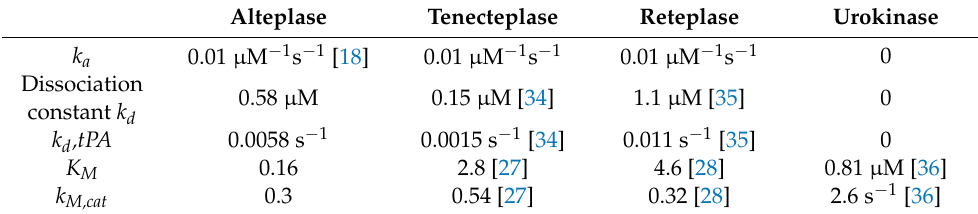
Table 2. Kinetic parameters for the simulated drugs in clot-phase